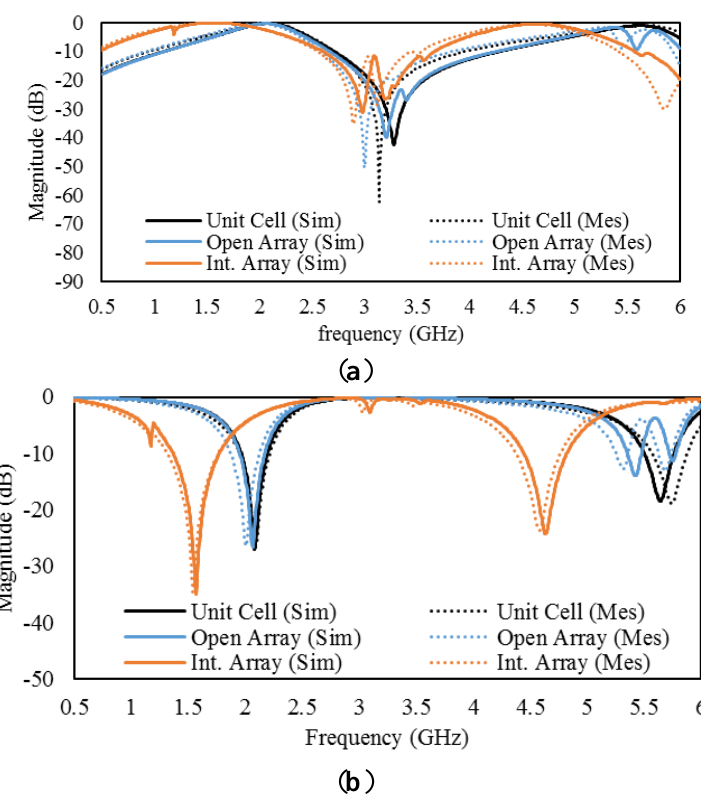
Figure 15. S parameters for unit cell A and arrays thereof: ( a ) reflection parameters (S and ( b ) transmission parameters (S